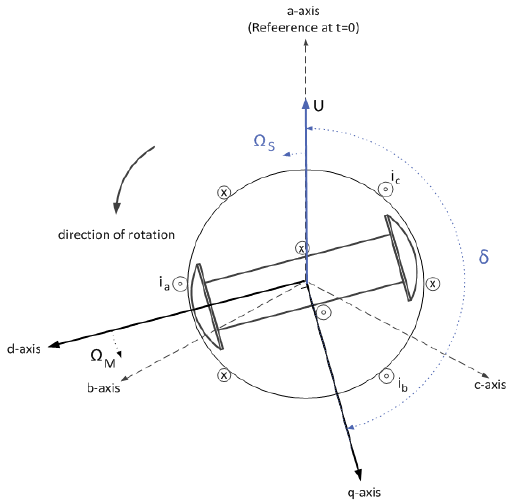
Figure 1: dq -frame in the synchronous machine and the angles